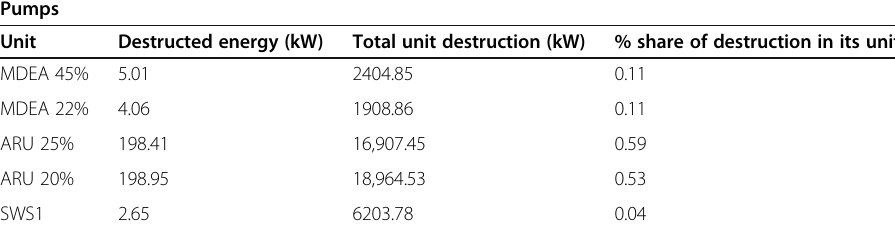
Table 13 Comparison between pumps destructions in three units Pumps Unit Destructed energy (kW) Total unit destruction (kW) % share of destruction in its